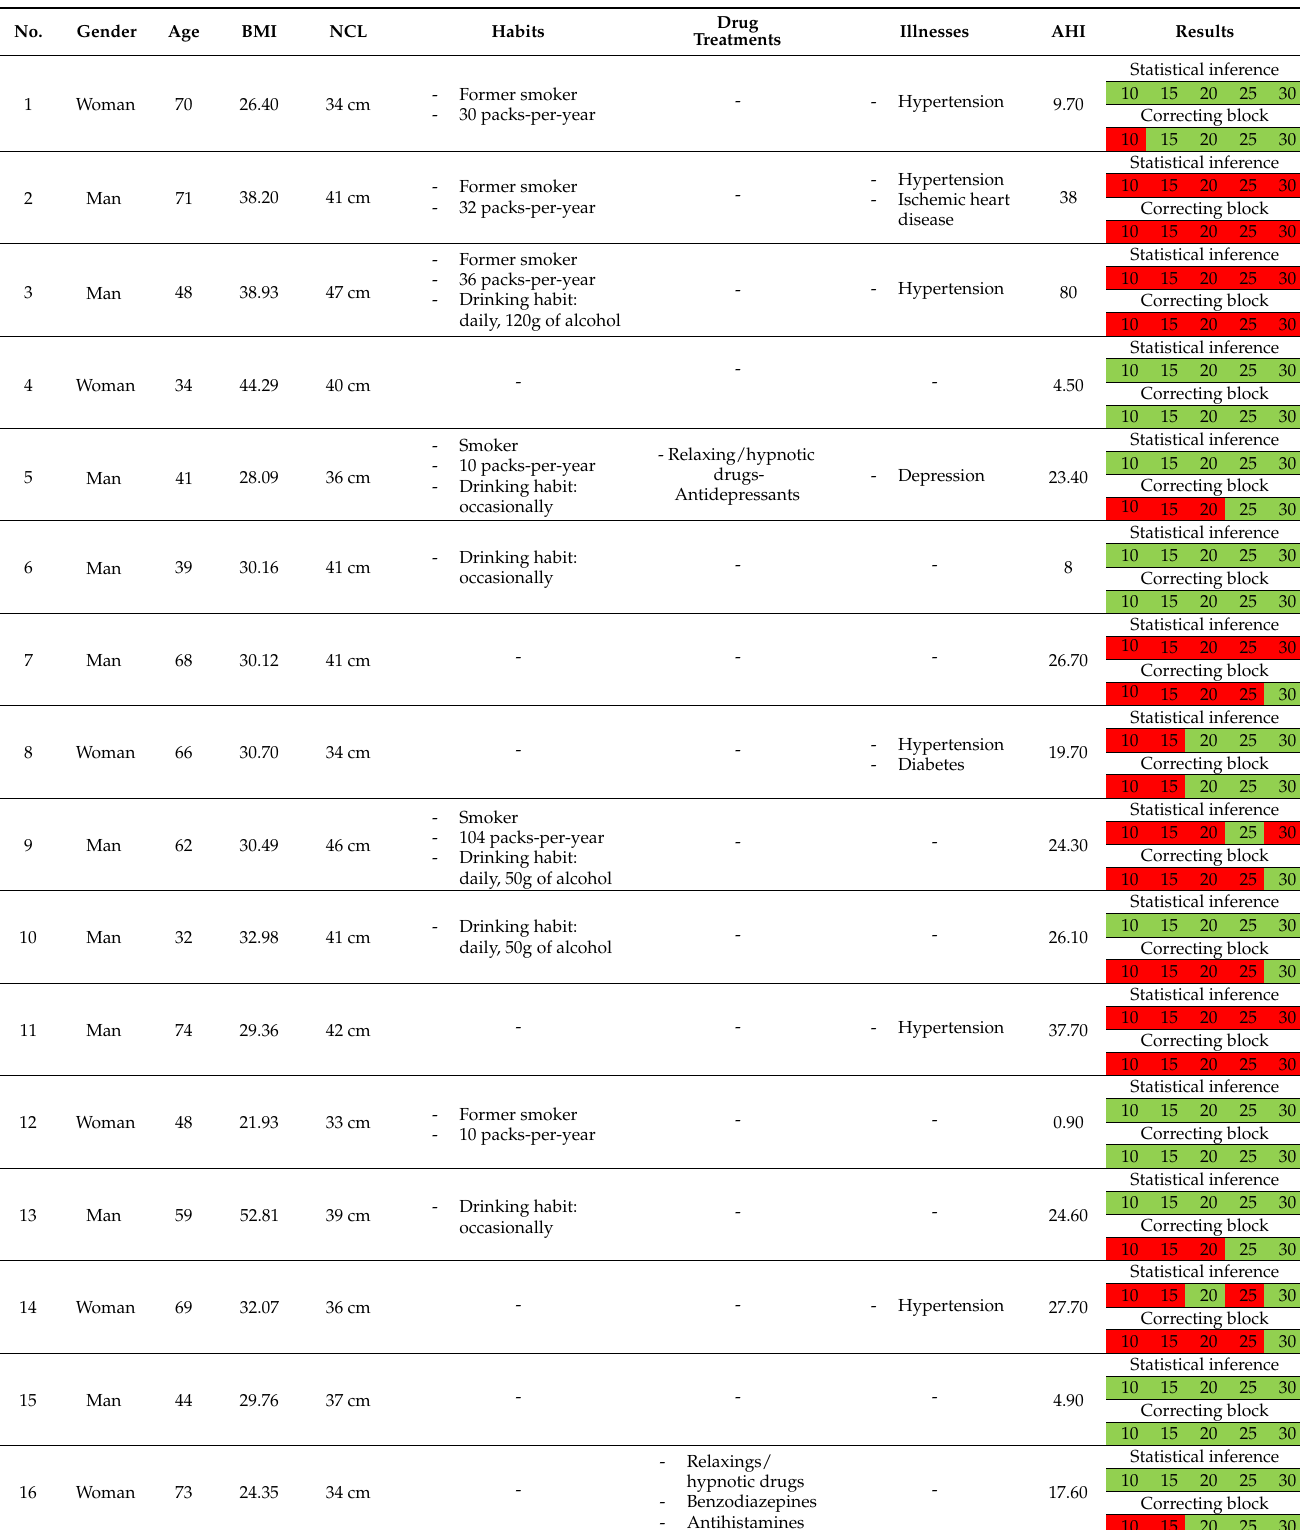
Table 16. Diagnostic proposed by the system for 20 cases. Background colors are related with the color of the light indicators associated to the different AHI levels. Red color shows the patient would present the corresponding AHI level. Otherwise, the color is